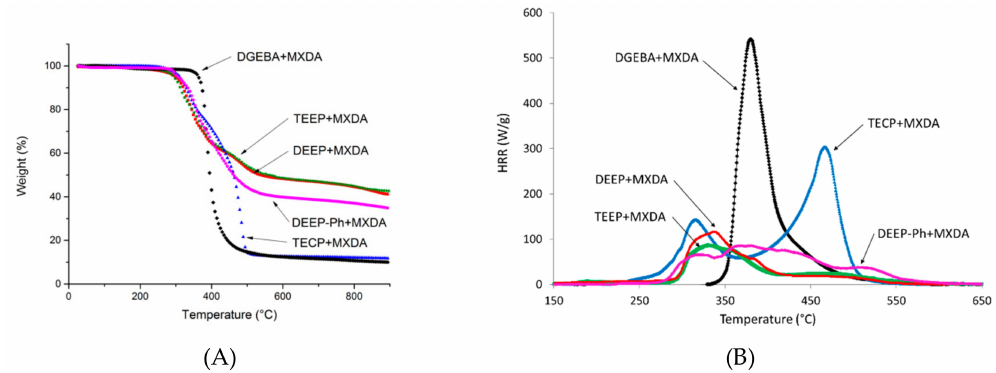
Figure 6. ( A -left) Thermograms of the cured materials ( B -right) Heat release rate versus temperature in pyrolysis-combustion flow calorimeter